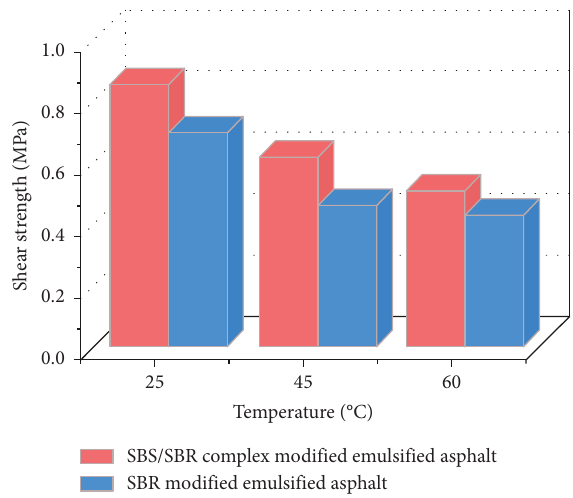
Figure 17: Variation of shear strength of diferent modifed emulsifed asphalt with